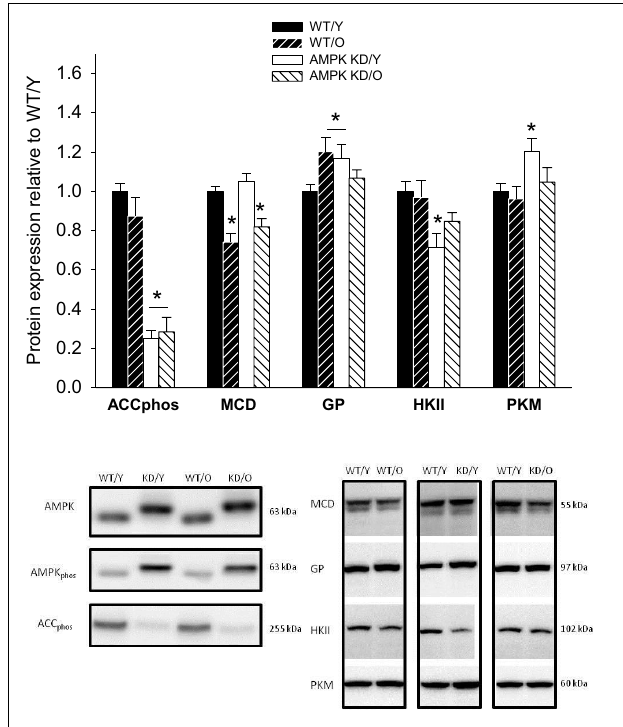
FIGURE 5 | Protein content (Western blot) of pS212 acetyl-CoA-carboxylase (ACC phos ) and malonyl-CoA-decarboxylase (MCD), glycogen-phosphorylase (GP), hexokinase II (HKII), and Pyruvatkinase (PKM) in heart muscle samples from wild type mice (WT) and dominant negativeAMPK α 2 (AMPK KD) mice. Young (Y: 19–22weeks) and old (O: 76–91weeks) mice were studied in both groups. Representative blots are shown in the lower panels, which also include blots of AMPK and AMPK phos . *Different fromWT/Y ( P < 0.05).